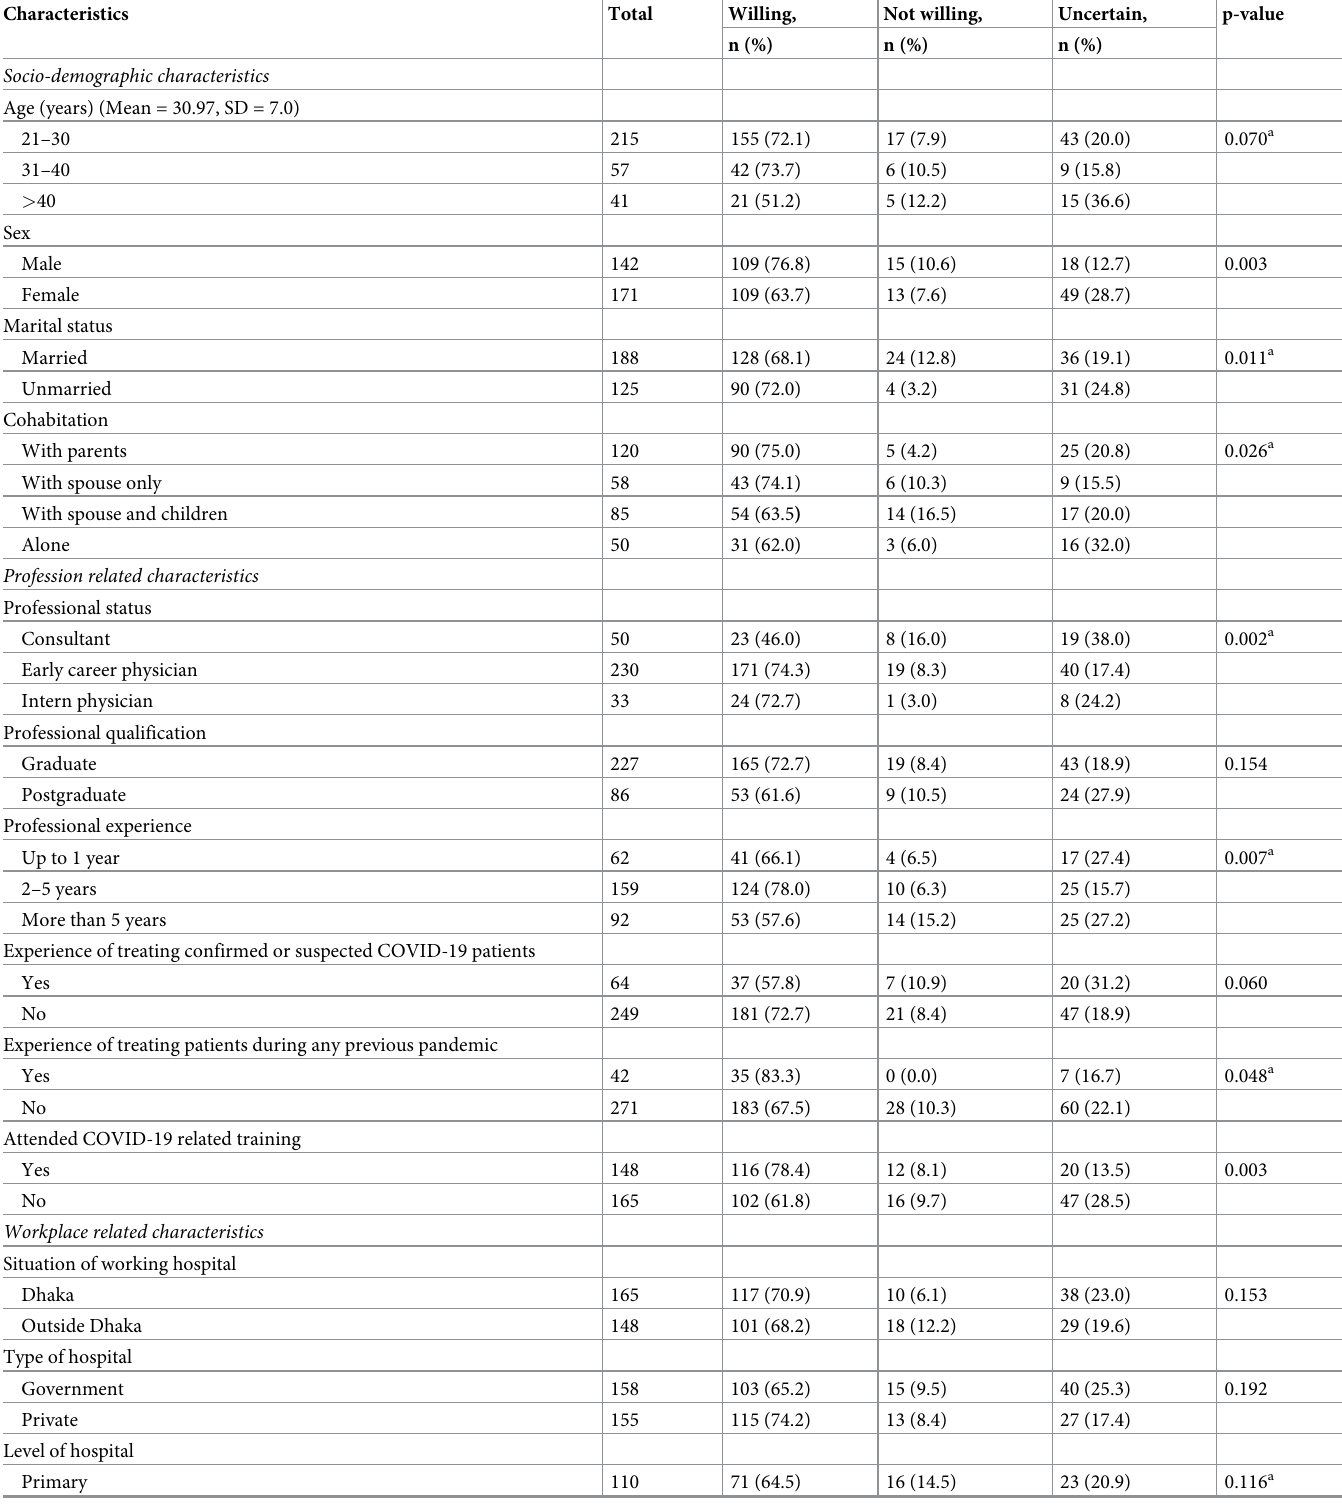
Table 1. Socio-demographic and professional characteristics of the participants (n = 313).